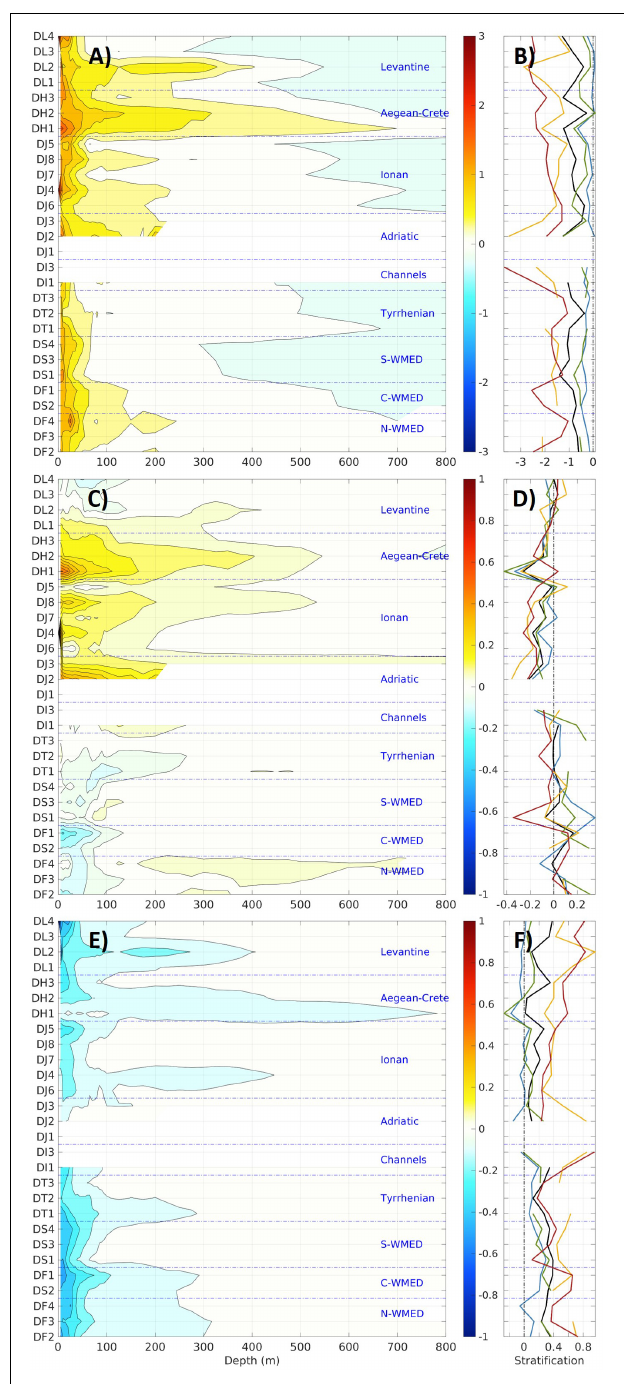
FIGURE 9 | Temperature (A,B) (in ◦ C), salinity (C,D) and density (E,F) (in kg/m3) anomalies: medians of the sub-regional distributions from MHW profiles over the period 2012–2020 as a function of depth (A,C,E) and associated upper-ocean stratification (B,D,F) .